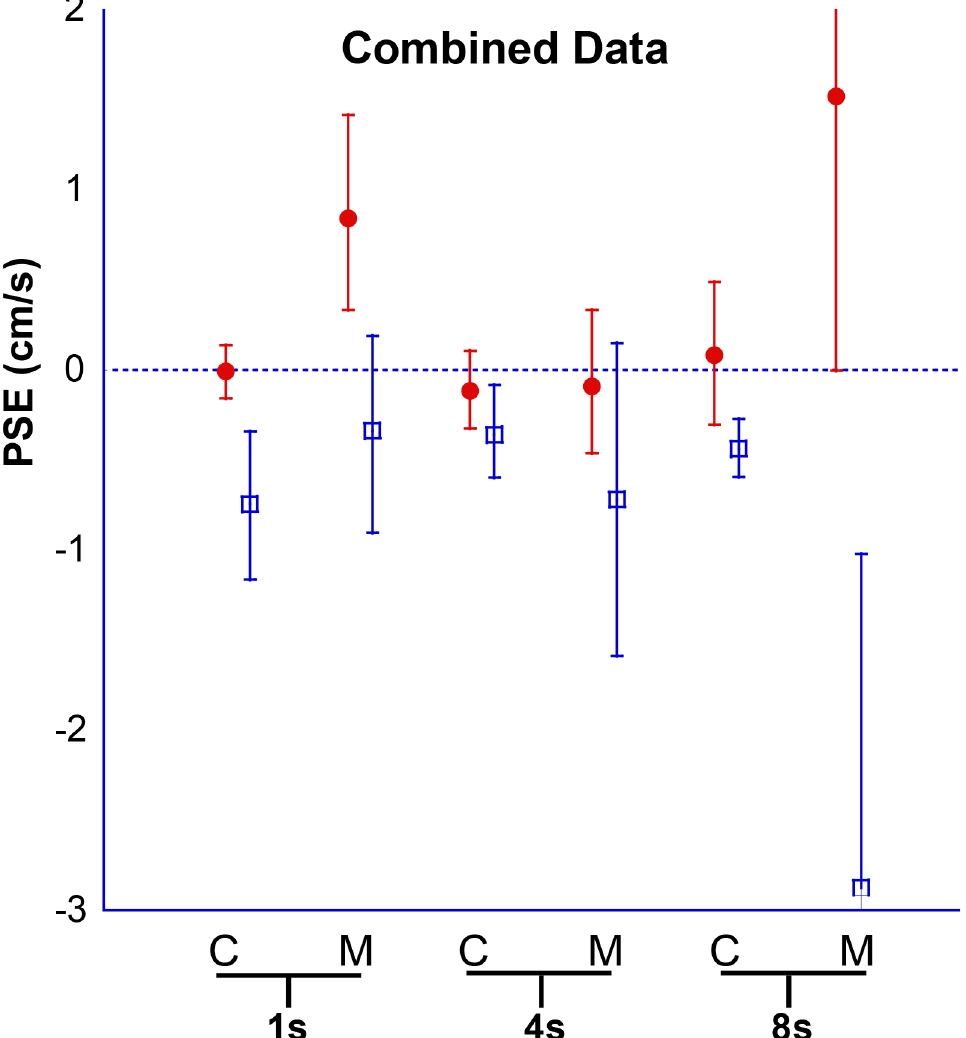
Fig 6. Combined data for PSE at 1s, 4s, and 8s. Looming VFM represented with red circles, receding VFM with blue squares. A positive PSE indicates that a neutral motion would be more likely to be perceived as forward self-motion, likewise a negative PSE indicates a neutral motion would be perceived as backwards. Error bars represent 95%